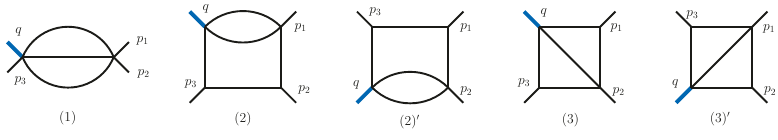
Figure 6 . Master integrals of F (2)